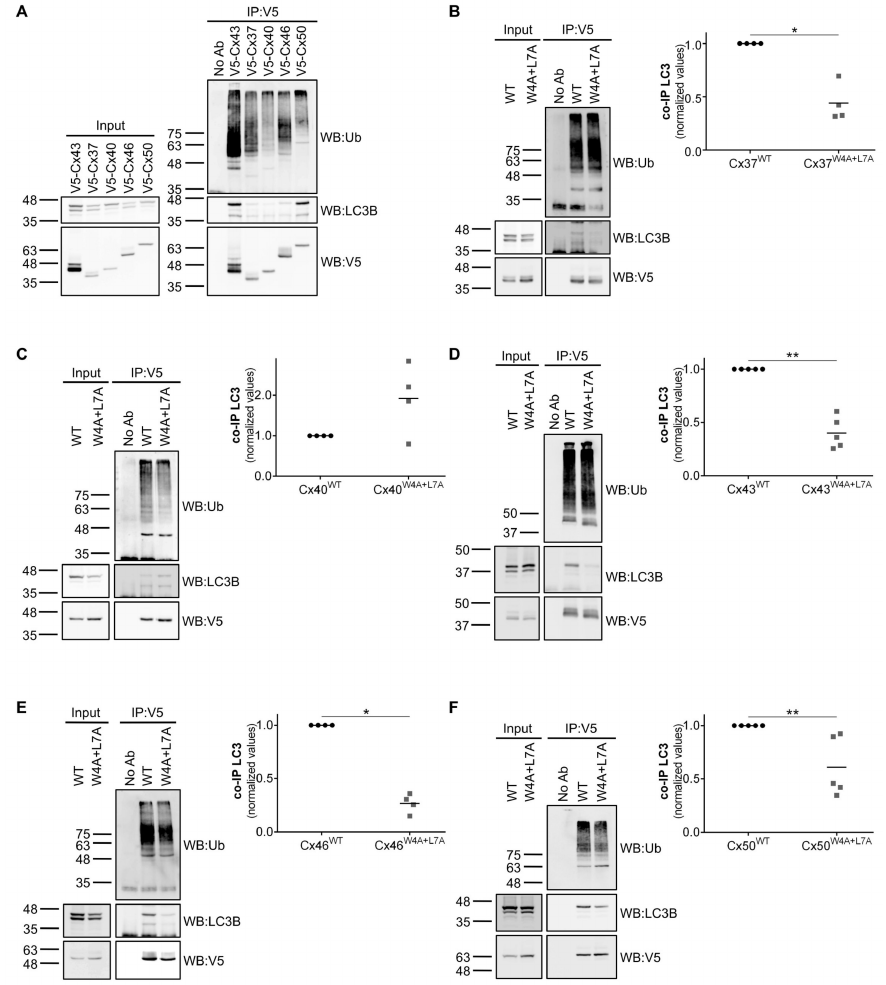
Figure 1. Connexin family members interact with LC3B through a LC3-interacting region (LIR) motif on their amino terminal. HEK293A cells were co-transfected with several di ff erent V5-connexin constructs and GFP-LC3B. Cell lysates were then subjected to immunoprecipitation with goat polyclonal antibodies against V5. The precipitates were analysed using Western blot using mouse monoclonal antibodies against V5 and ubiquitin, or rabbit polyclonal antibodies against LC3B ( A ). HEK293A cells were co-transfected with GFP-LC3B and V5 constructs of either wild type or W4A + L7A mutants of Cx37 ( B ), Cx40 ( C ), Cx43 ( D ), Cx46 ( E ) and Cx50 ( F ). Cell lysates were then subjected to immunoprecipitation with goat polyclonal antibodies against V5. The precipitates were analysed using Western blot using mouse monoclonal antibodies against V5 and ubiquitin, or rabbit polyclonal antibodies against LC3B. The level of co-immunoprecipitated LC3B with each connexin was quantified, normalized to the immunoprecipitated connexin and plotted. * p < 0.05, ** p < 0.01, ns: non-significant using the Mann-Whitney